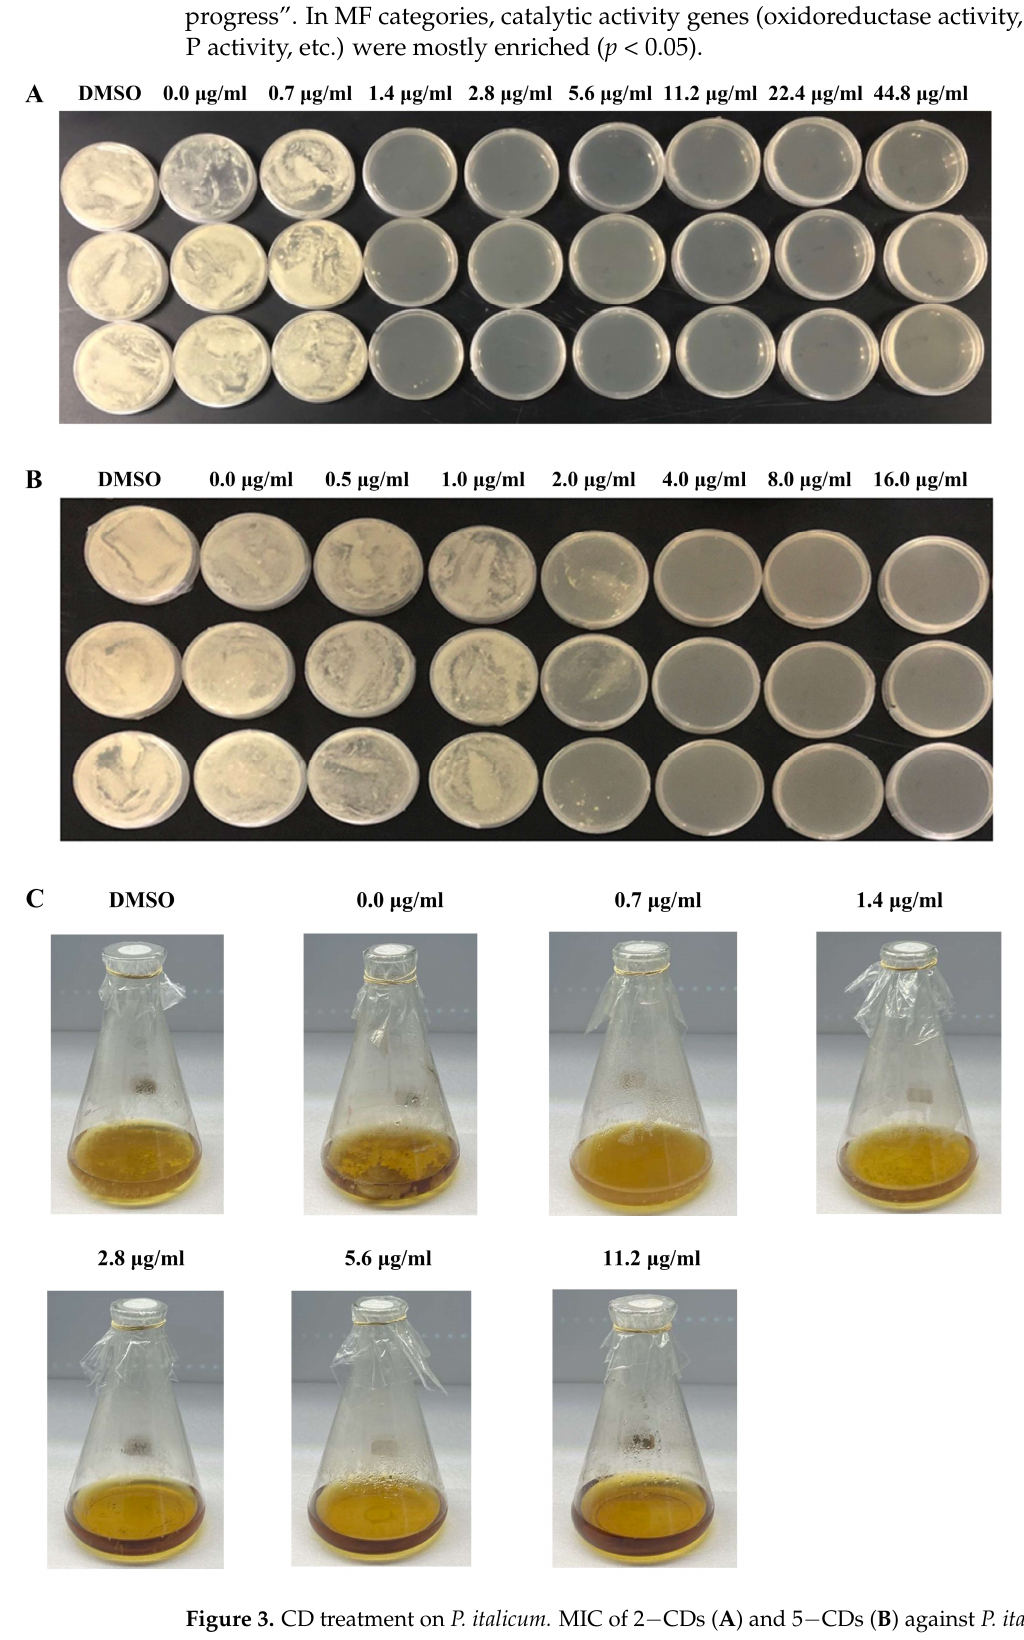
Figure 3. CD treatment on P. italicum. MIC of 2 − CDs ( A ) and 5 − CDs ( B ) against P. italicum (48 h) on PDA dishes; every dish line indicates one replicate; MIC of P. italicum after 2 − CDs s treatment (48 h) in PDB liquid medium ( C ).